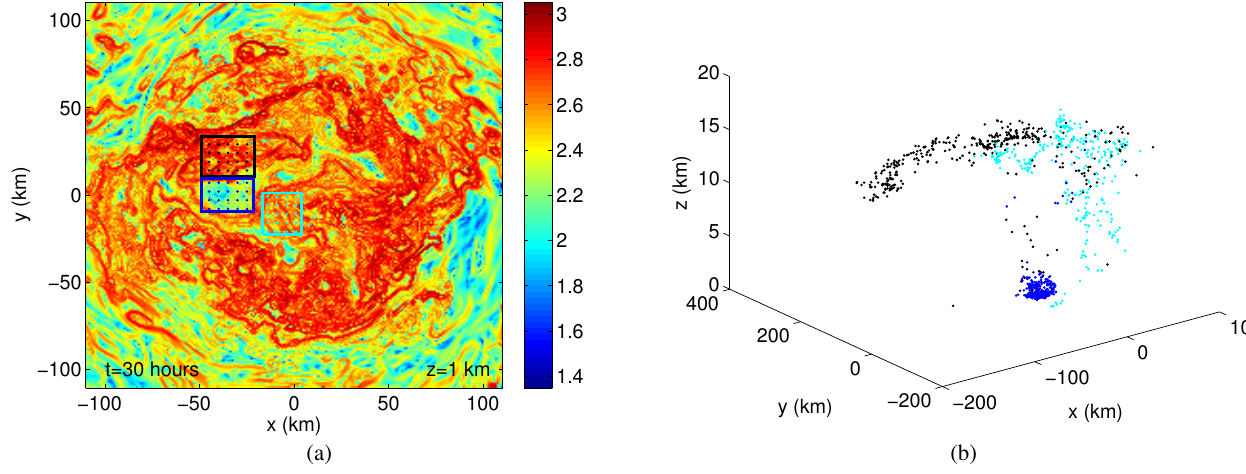
Fig. 6. LCSs from the planar FTLE field are shown at z = 1 km (a) with initial particle locations shown as blue, cyan and black dots. The final locations of the particles after a 4 hour integration are shown in